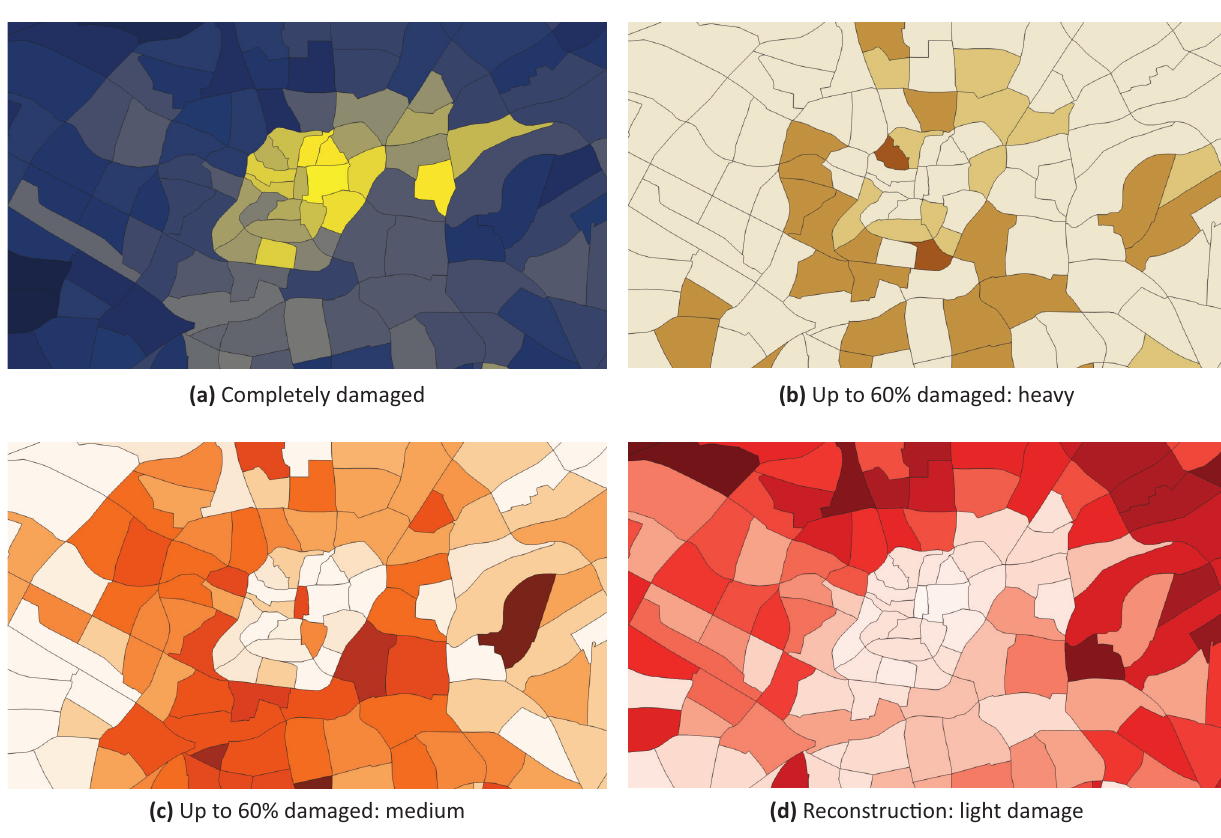
Figure 3. The four damage categories (excluding undamaged buildings) were recorded at the district level to reflect the damage shown on the historical map detail from Figure 2. Note: Lighter colours show higher levels of complete damage (a) ; darker shades show higher levels of damage for each legend category (b) , (c) , (d)